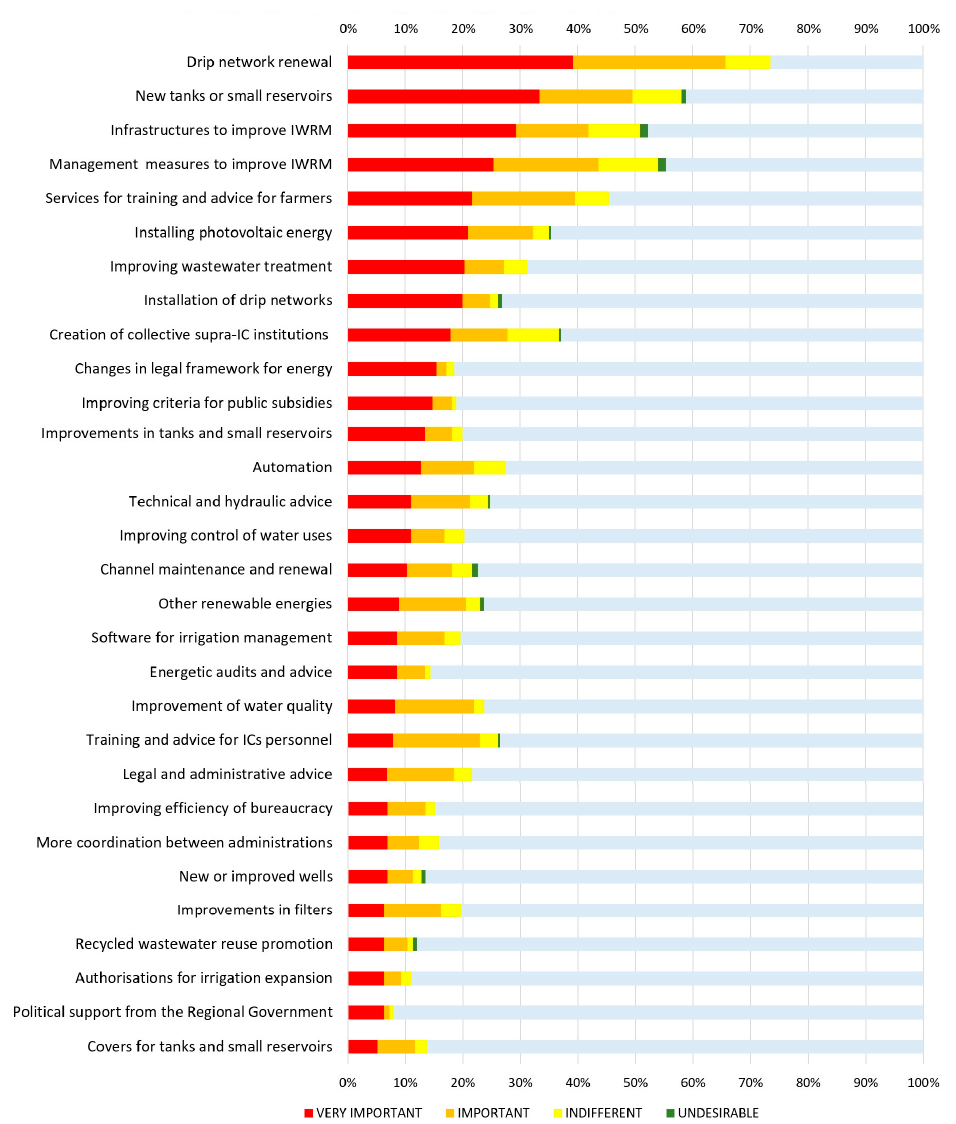
Figure 6. Measure evaluation: results of the attendee assessment evaluated in terms of percentage of total votes.